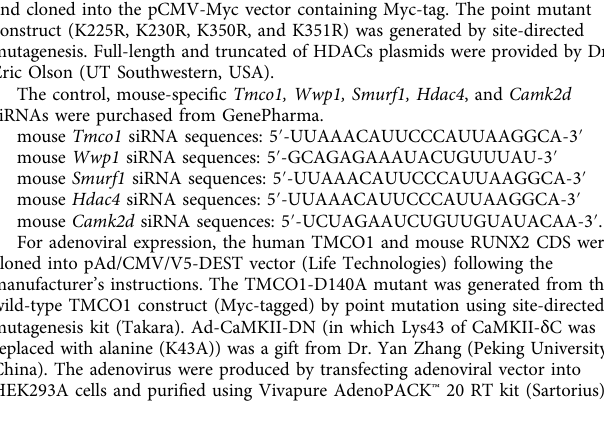
mouse Smurf1 siRNA sequences: 5 ′ -UUAAACAUUCCCAUUAAGGCA-3 ′ mouse Hdac4 siRNA sequences: 5 ′ -UUAAACAUUCCCAUUAAGGCA-3 ′ mouse Camk2d siRNA sequences: 5 ′ -UCUAGAAUCUGUUGUAUACAA-3 ′ . For adenoviral expression, the human TMCO1 and mouse RUNX2 CDS